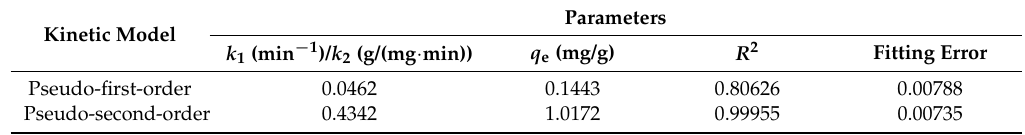
Table 1. Kinetic parameters for the pseudo-first-order and pseudo-second-order